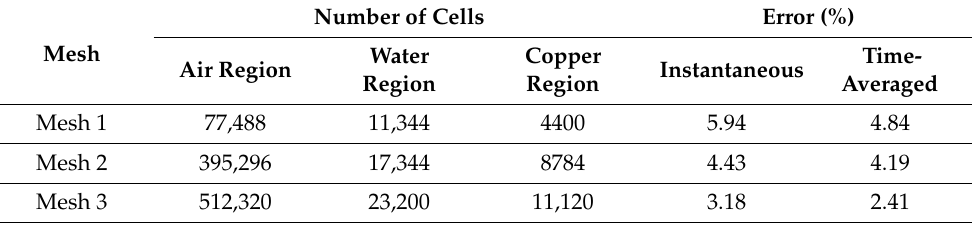
Table 2. Mesh-independence study for instantaneous and time-averaged data. Mesh